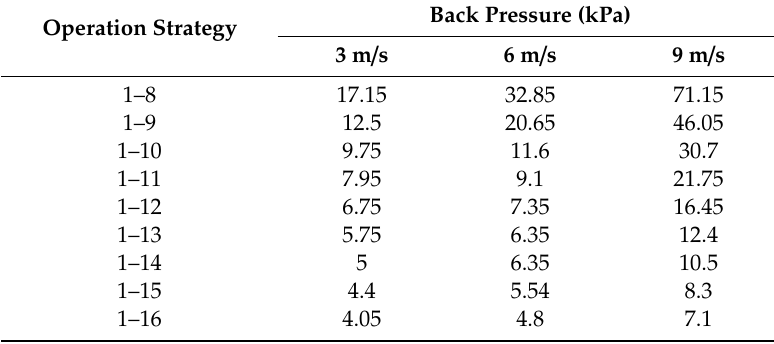
Table 4. Backpressure with the number of ACC cells under di ff erent ambient winds in − 15 ◦